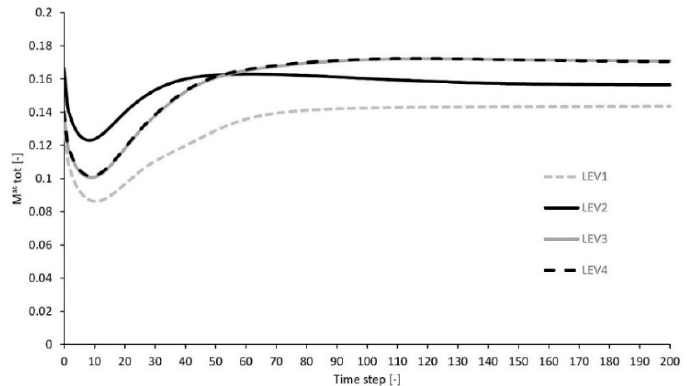
Figure 6. Evolution and the reaching of equilibrium values for each scenario relative to the gener- alized bio-energy of all the systems’ M as tot (standardized values).